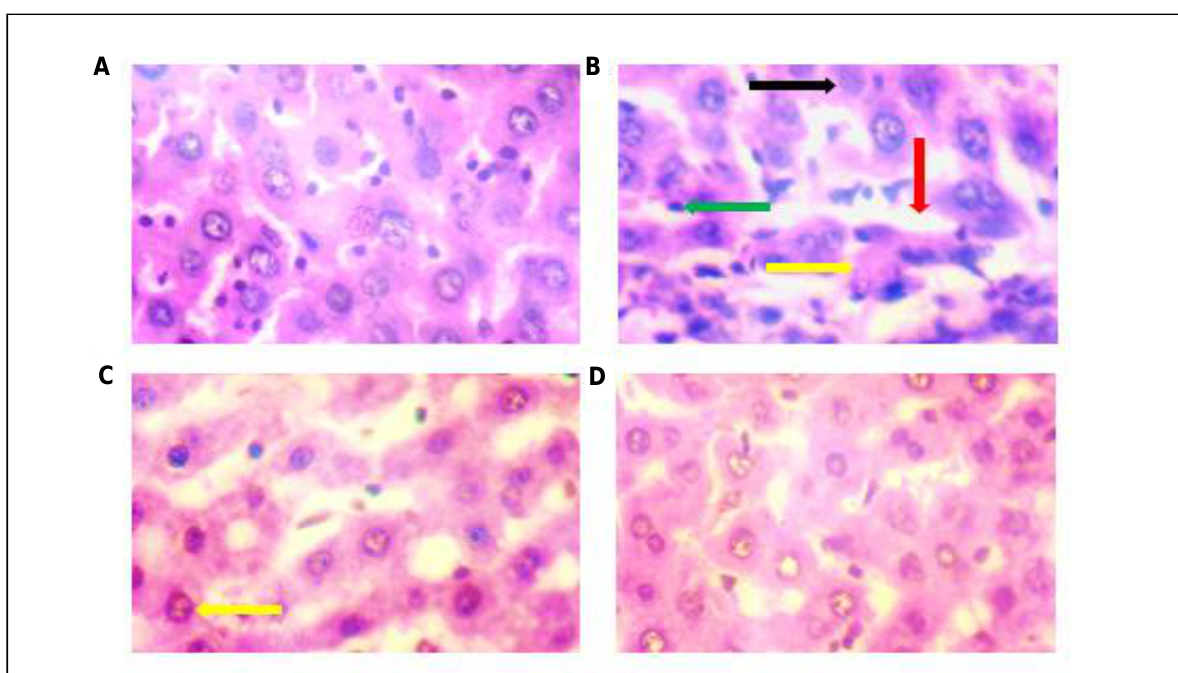
1: Photomicrograph of liver histology for group A (control group) with normal liver histologic features; group B (induced with 100 mg/kg b.w. of KBrO ) with complete loss of cyto and histoarchitecture showing 3 dilated portal area (dp), portal area infiltrated by inflammatory cells, dilated sinusoids (c), hepatocyte necrosis (yellow arrow), karyolysis (black arrow) and pyknosis (green arrow); group C (induced with KBrO and treated 3 with 200 mg/kg b.w. of AETO) showing signs of recovery in the hepatocytes and central vein; group D (induced with 100 mg/kg b.w. of KBrO and treated with 500 mg/kg b.w. of AETO) showing a nearly normal liver 3 histoarchitecture. H & E; Magnification